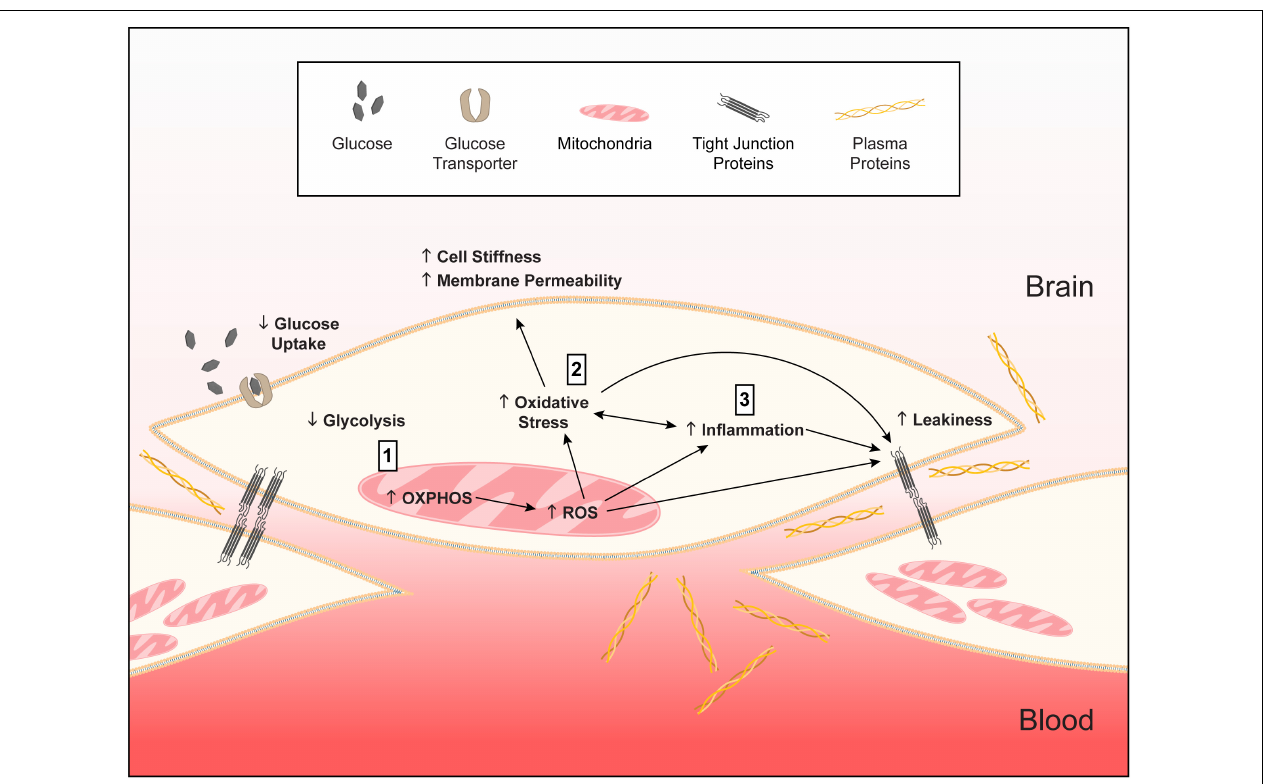
FIGURE 12 | Working model of APOE -modulated brain endothelial cell function. ↓ = lower and ↑ = higher for APOE4 compared to APOE3 . We propose that (1) APOE4 brain endothelial cells have higher preference for oxidative phosphorylation (OXPHOS) compared to glycolysis. Lower glycolysis is evident in ATP rate assays, lower rate of glucose uptake and higher lactate production. Due to OXPHOS there is higher peroxisome and mitochondrial activity indicated by higher hydrogen peroxide degradation, mitochondrial membrane potential, citrate synthase activity and levels of electron transport chain complexes. Higher mitochondrial activity leads to the generation of reactive oxygen species, particularly superoxide, and lower levels of antioxidant systems, including heme and glutathione. (2) Higher reactive oxygen species lead to more oxidative stress to proteins (e.g., carbonylation) that must be cleared by proteasome activity. Oxidative stress to lipids (peroxidation, production of TBARS) alters membrane structures (lower phospholipids, higher ceramides) that manifests as higher cell stiffness and plasma membrane permeability. (3) Either in parallel or due to higher mitochondrial activity, inflammation pathways are activated with APOE4 . APOE4 -assocaited inflammation is characterized by chemokine production, immune cell adhesion and higher sensitivity of innate receptors to activation (e.g., TLR4). The combination of all these changes leads to higher basal transcellular permeability with APOE4 . Therefore, autocrine signaling of apoE in brain endothelial cells represents a novel cellular mechanism for how APOE regulates neurovascular function. We further propose that this pathway is not necessarily detrimental in basal conditions for APOE4 and may even be beneficial for responding to infections and other stressors earlier in life. However, chronic changes in metabolic, mitochondrial, or inflammatory pathways in neurodegenerative conditions could lead to brain endothelial cell